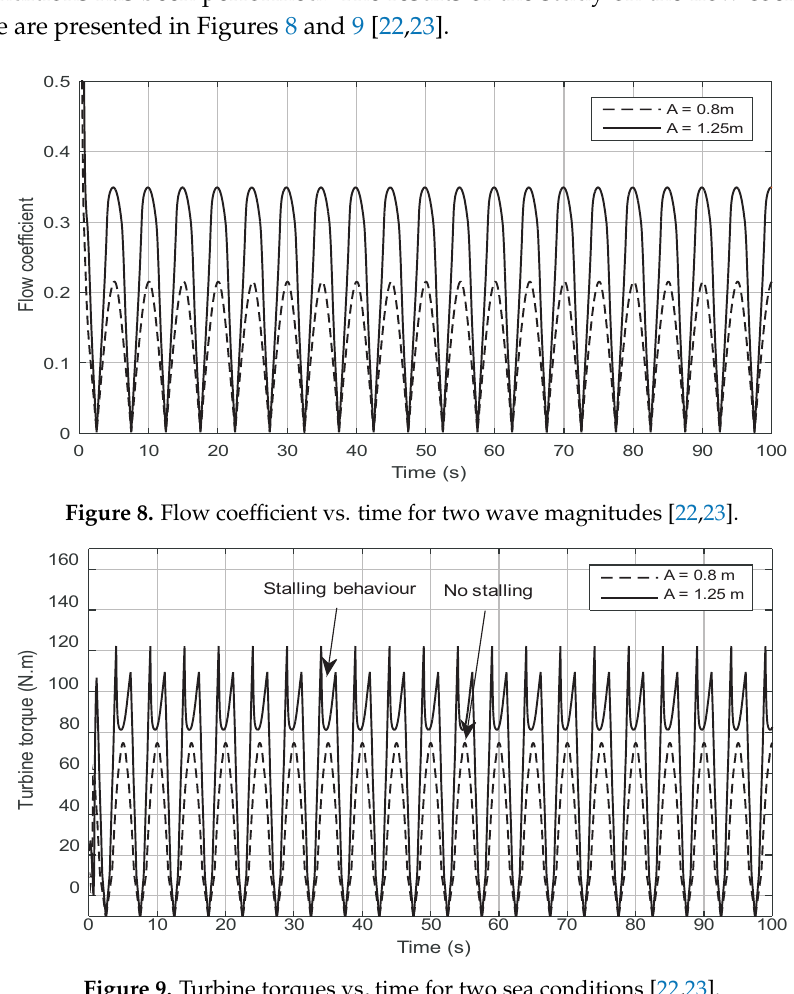
Figure 9. Turbine torques vs, time for two sea conditions